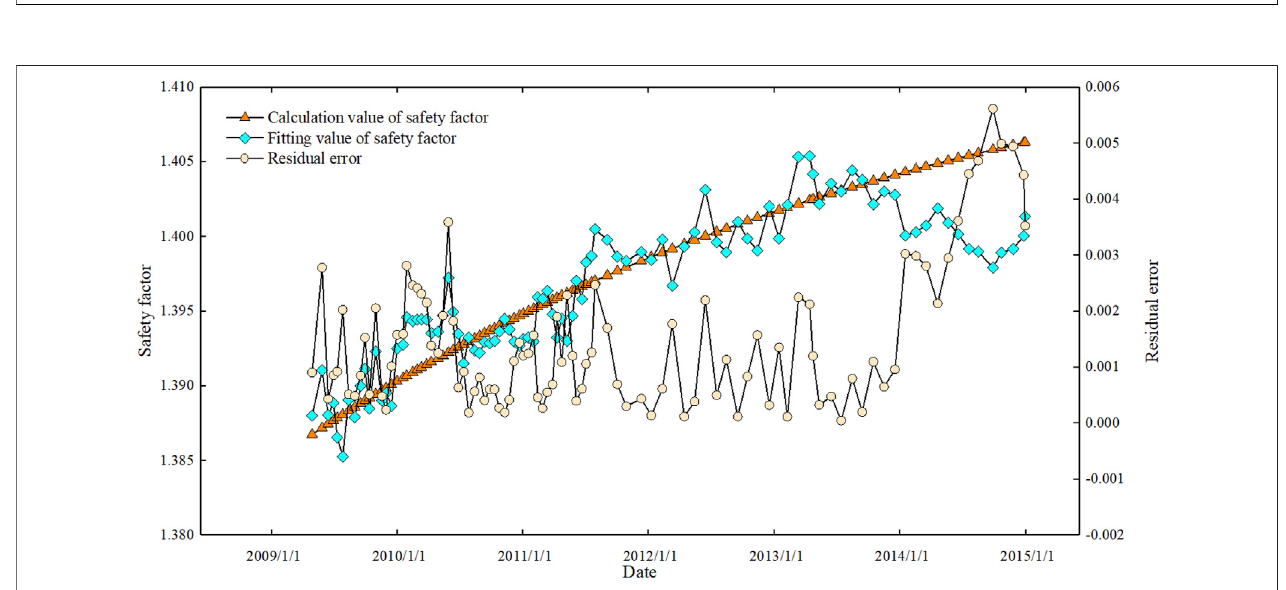
FIGURE 12 | Process line of the stability safety coef fi cient of the left bank slope.